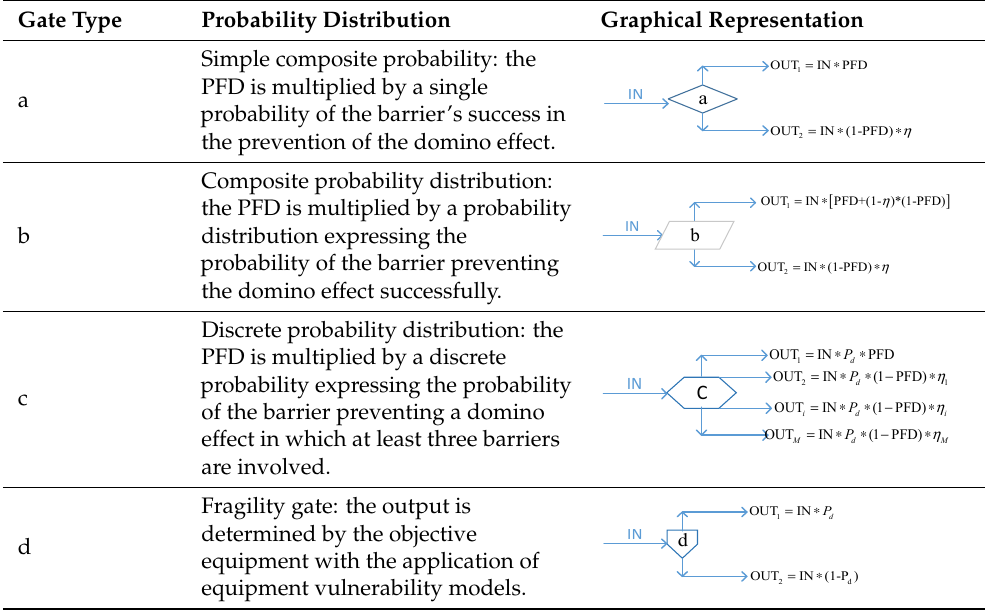
Table 5. Definitions and associated operators for different gate types [49]. Gate Probability Distribution Graphical Type